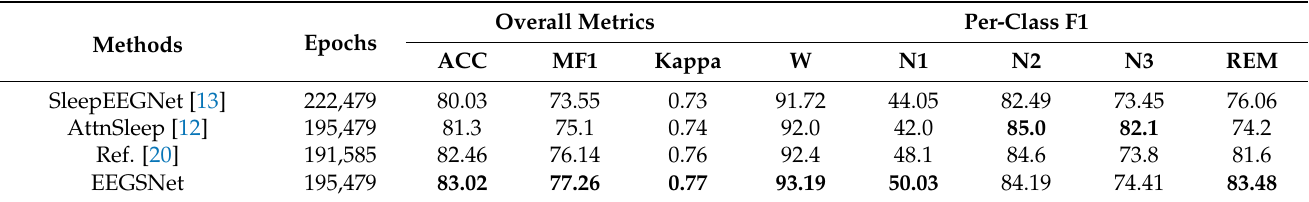
Table 9. Comparison of performance metrics obtained by our method with other state-of-the-art algorithms on Sleep-EDFX-78.